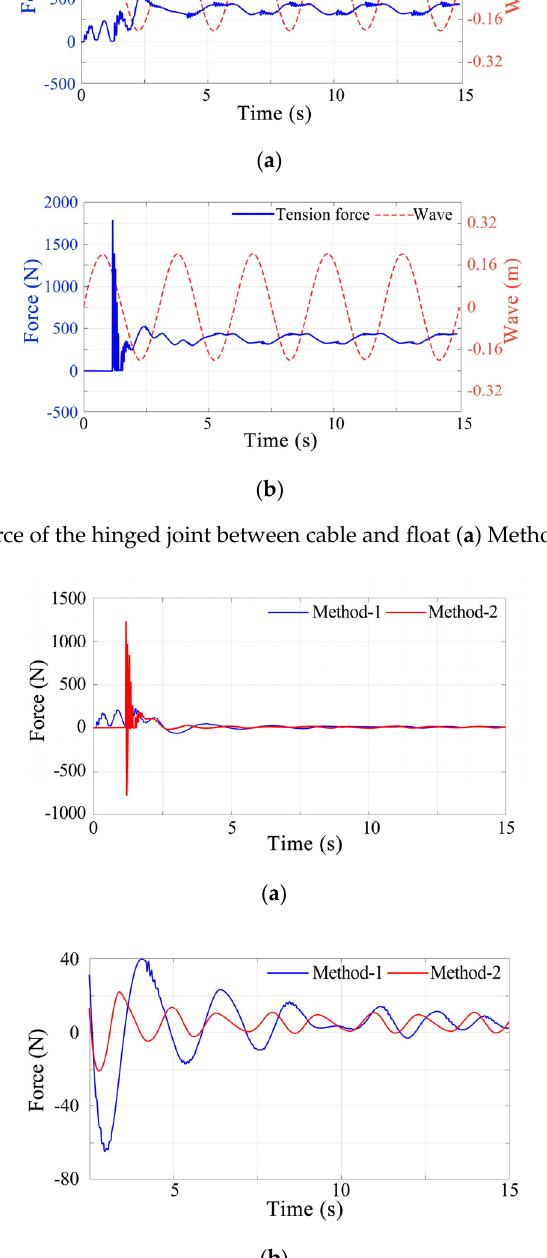
Figure 12. Hydrofoil thrust in horizontal direction. 4. Conclusions In this paper, a 3-DOF dynamic model of a wave glider was established based on the multibody dynamic method. The dynamic characteristics of the deployment process were calculated by the